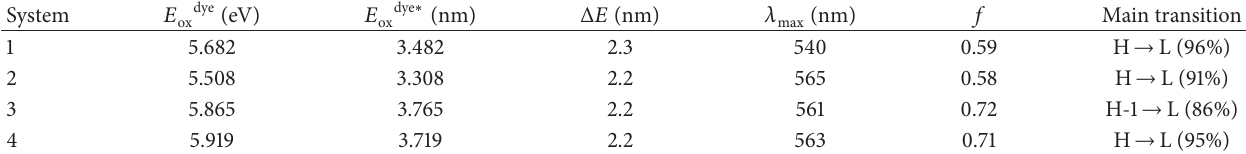
Table 2: Optical, redox potentials, oscillator strengths, and major transitions of oxadiazole based photosensitizers.